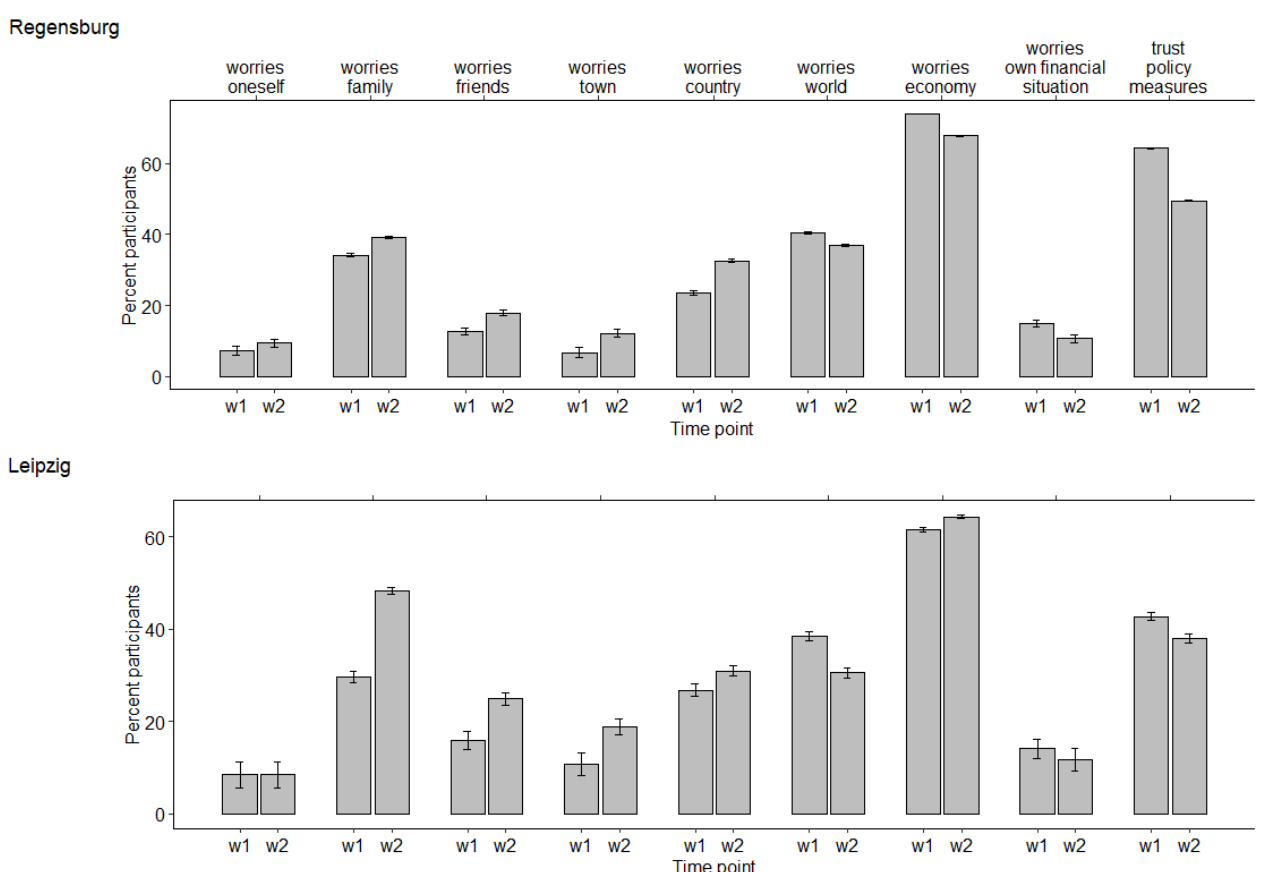
Figure 2. Percentage (+95% CI) of COVID-19 related worries and trust in policy measures in Regensburg and Leipzig at wave 1 (w1) and wave 2 (w2). For clarity, only the percentages of participants indicating that they worry (or trust) “very much” or “extremely” are presented. Table 2. Effects of time (wave 1 versus wave 2) and region (Leipzig versus Regensburg) on COVID- 19-related worries and trust in policy measures.